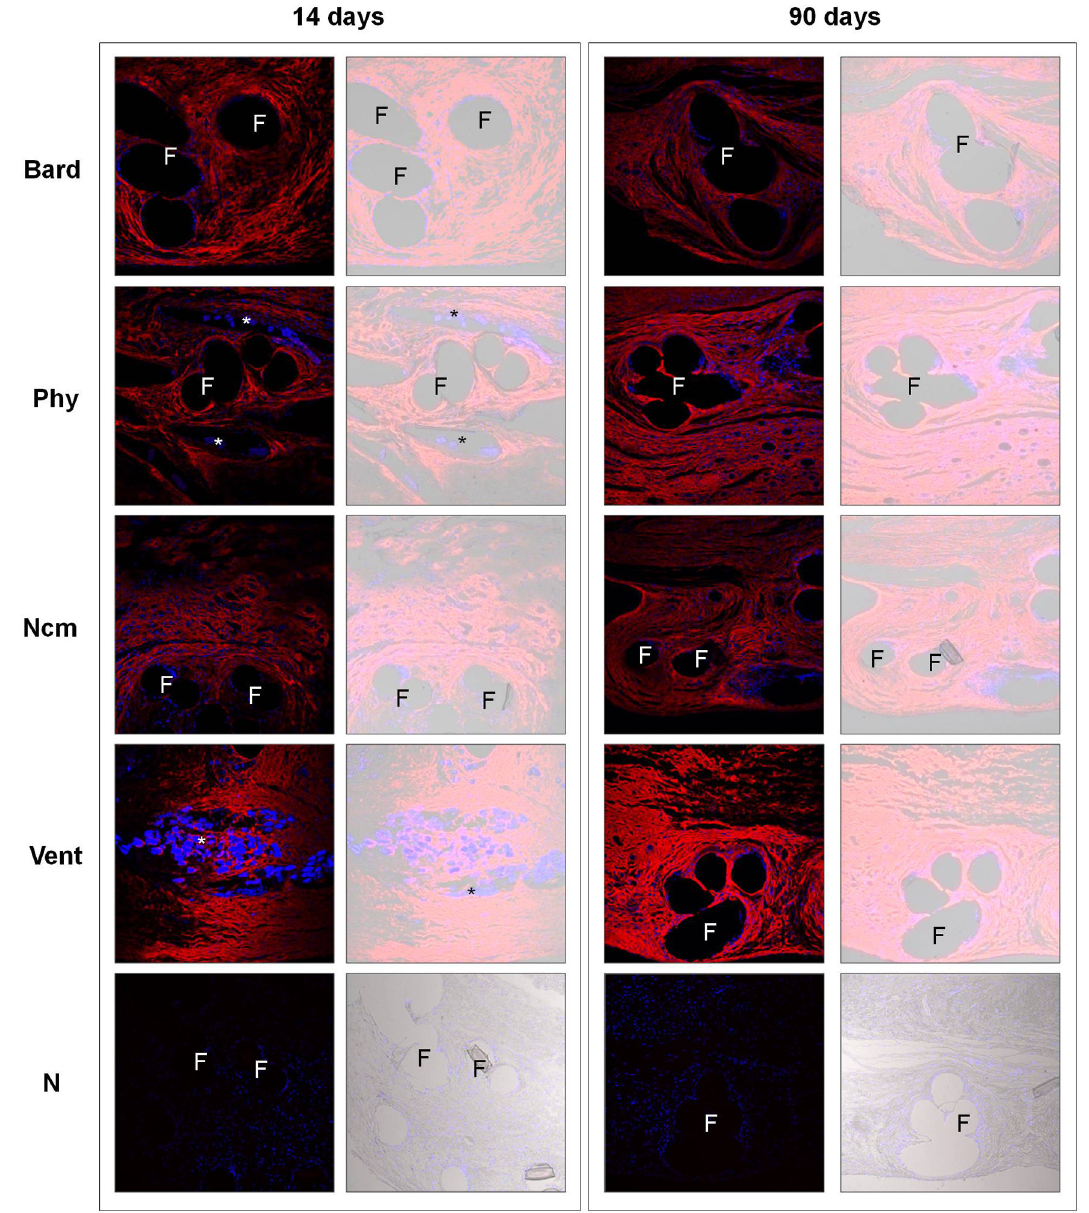
Figure 4. Collagen type III expression. Immunofluorescence detected for collagen type III at 14 and 90 days postimplant (left panel). N=negative controls; new composite mesh (NCM) 14 days and Ventralight TM (VL) 90 days. Neoformed collagen appears red and cell nuclei (stained with DAPI) appear blue. In the DIC images, the biomaterial appears translucent (right panel). Confocal light microscopy (200x). Subcutaneous tissue (s), prosthetic filaments (F), polyglycolic acid or polyglecaprone (*). doi: 10.1371/journal.pone.0080647.g004 days postimplant, significantly lower collagen 1 mRNA Collagen 3 mRNA levels recorded for Bard mesh and Ncm expression was detected for Bard mesh compared to Phy , Ncm were significantly reduced between the two time points by 62% and Vent (p<0.01, p<0.05 and p<0.01 respectively). Vent (p<0.05) and 32% (p<0.05) respectively, as occurred with showed almost three times the expression noted for Bard collagen 1. Levels associated with Phy were double (p<0.05) mesh . No significant differences in collagen 1 mRNA those detected at 14 days. For Vent , collagen 3 mRNA levels expression levels were detected between Phy , Ncm and Vent . were similar at both time points.